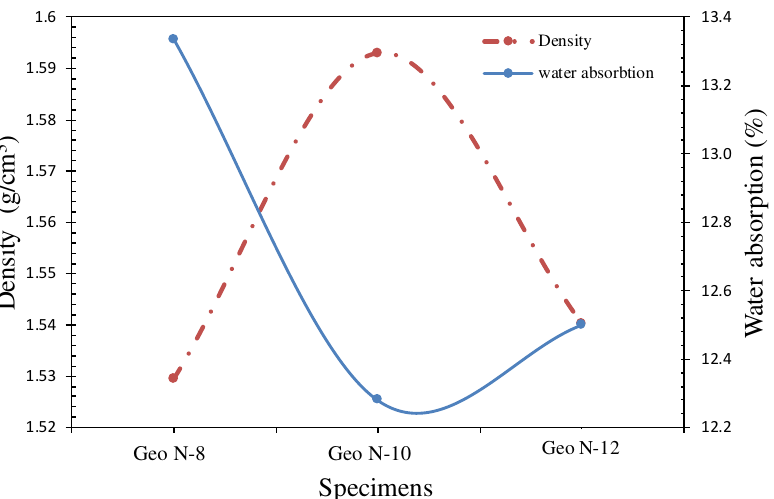
Figure 5. Density and water absorption values with various NaOH concentrations in sodium sili- cate .